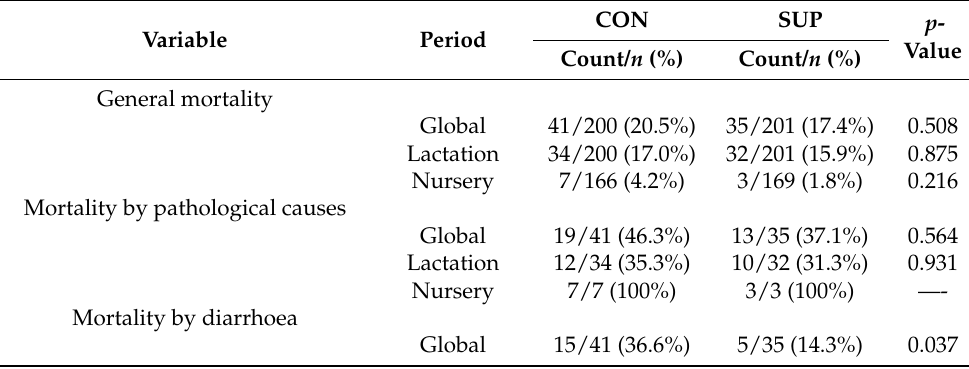
Table 10. General mortality and mortality by pathological cause (global and by age) and mortality by diarrhoea (global) in the CON and SUP groups. CON: control group; SUP: colostrum supplemented group. Comparisons between groups were made by using Pearson’s Chi-squared test. Fisher’s exact test was used for mortality by